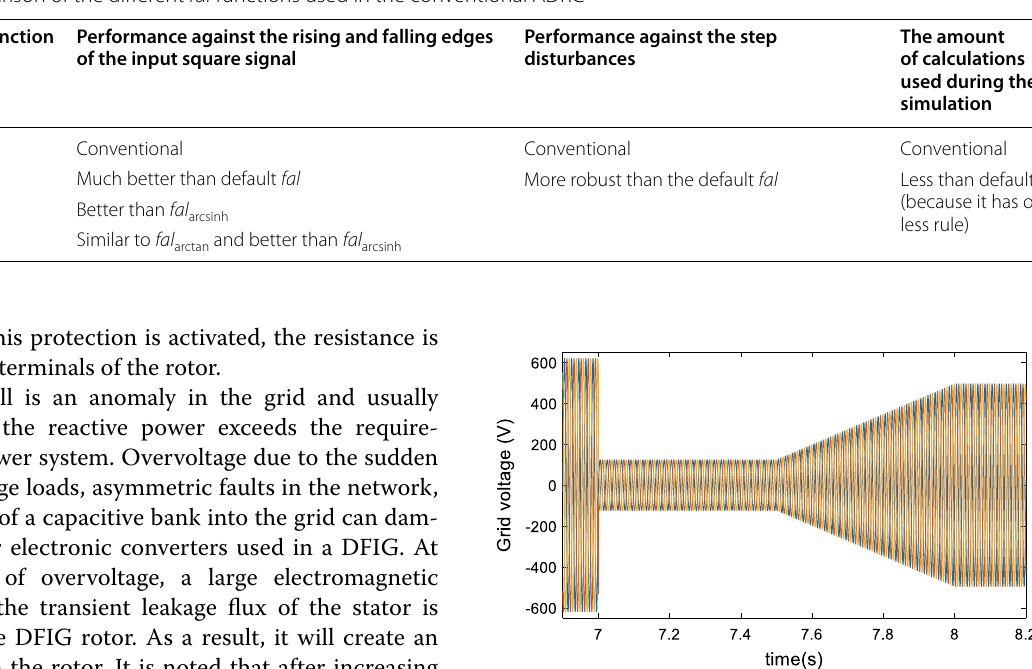
Fig. 14 Network voltage during symmetrical voltage sag (Spanish network